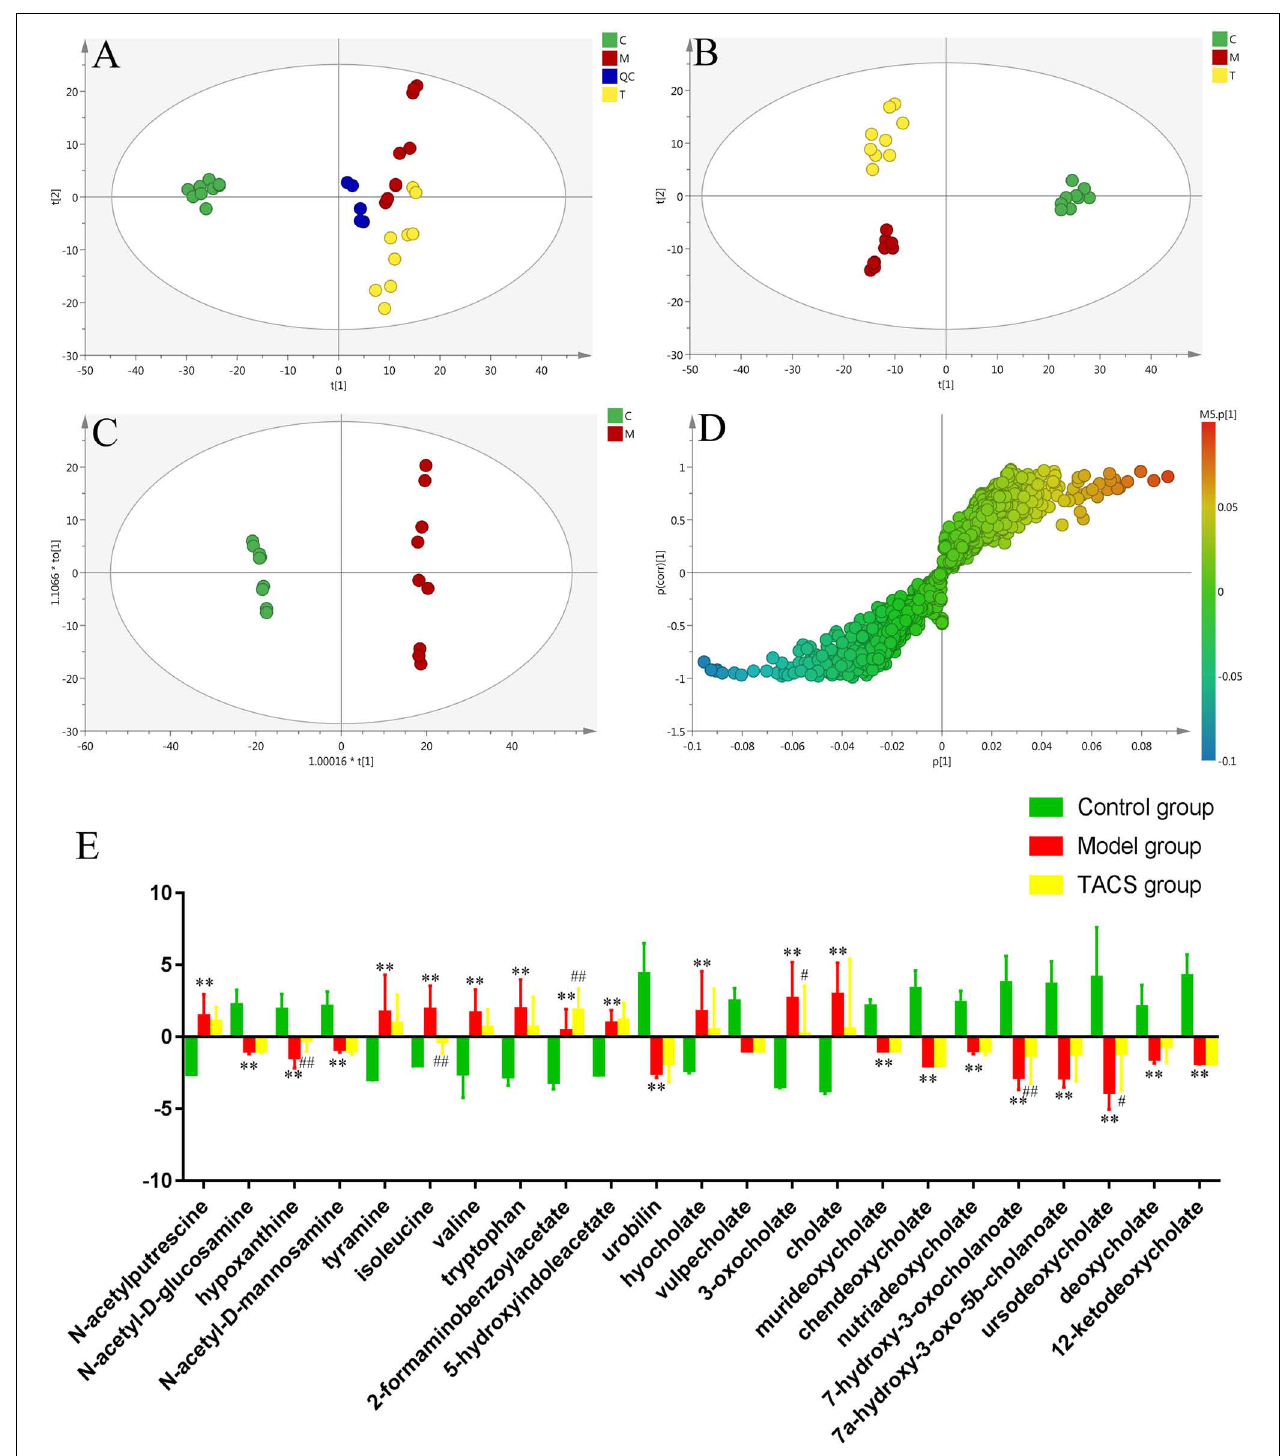
FIGURE 3 | Principal component analysis score plot of fecal samples collected from different rat treatment groups in the positive mode ( A , R 2 X = 0.535, Q 2 (cum) = 0.202). PLS-DA score plot of fecal samples collected from different rat treatment groups in the positive mode [ B , R 2 X = 0.42, R 2 Y = 0.987, Q 2 (cum) = 0.917]. OPLS-DA score plot and S-plot of the control and antibiotic-only groups in the positive mode (C,D) . (C), control group; (M), antibiotic-only group; (T), TACS group; and (QC), quality control group. Significant changes in fecal metabolites in different groups are shown in the histogram (E) . (Antibiotic-only group vs. control group: ∗ p < 0.05; ∗∗ p < 0.01; TACS group vs. model group: # p < 0.05; ## p <